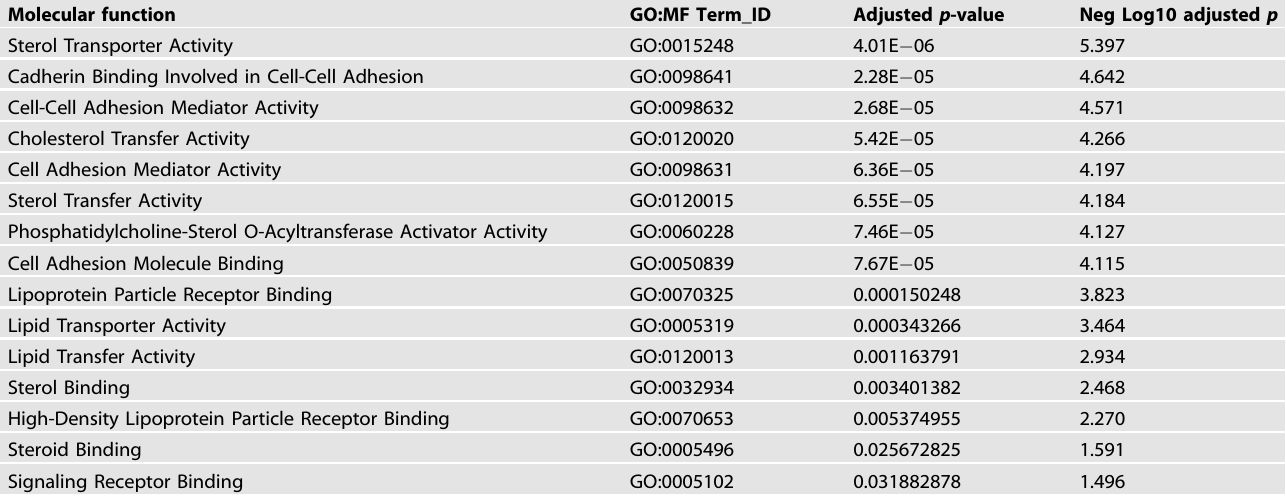
Table 6. Up-regulated GO molecular functions in Scz organoids ( p <